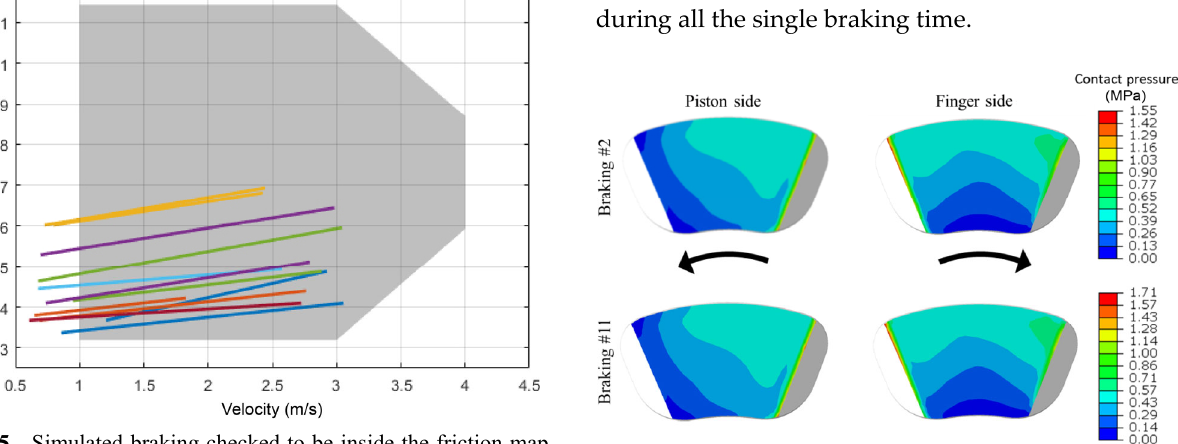
Fig. 5 Simulated braking checked to be inside the friction map with a tolerance of 5%. Every line in the figure represents a single brake event.